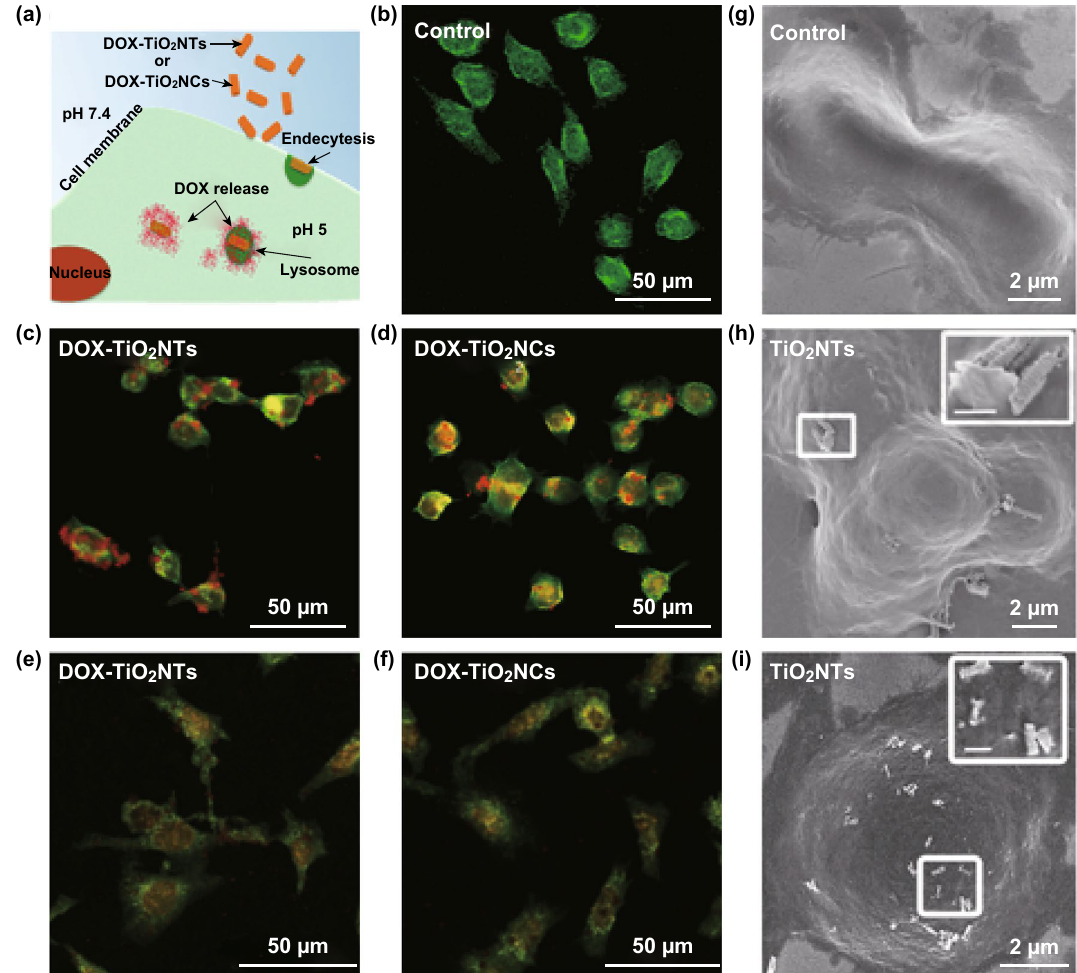
Fig. 4 Internalization of DOX‑loaded TiO 2 nanotubes and nanocylinders into HeLa cells. (I) The cellular uptake and intracellular DOX release from TiO 2 NSs confirmed by scanning electron microscopy (SEM) and confocal microscopy images of control (‑I‑control) HeLa cells without the nanocarriers, DOX‑conjugated TiO 2 NTs (‑I‑DOX‑TiO 2 NTs, red demarcation) and DOX‑conjugated TiO 2 NCs (‑I‑DOX‑TiO 2 NCs, red demar‑ cation) after 1 h and 24 h of incubation. Cells were stained with fluorescein diacetate (green). Insets indicate the magnified images of internal‑ izing TiO 2 nanotubes and nanocylinders. Scale bars of the inset frames are 500 nm. Adapted from Ref. [10] with permission from the American Chemical